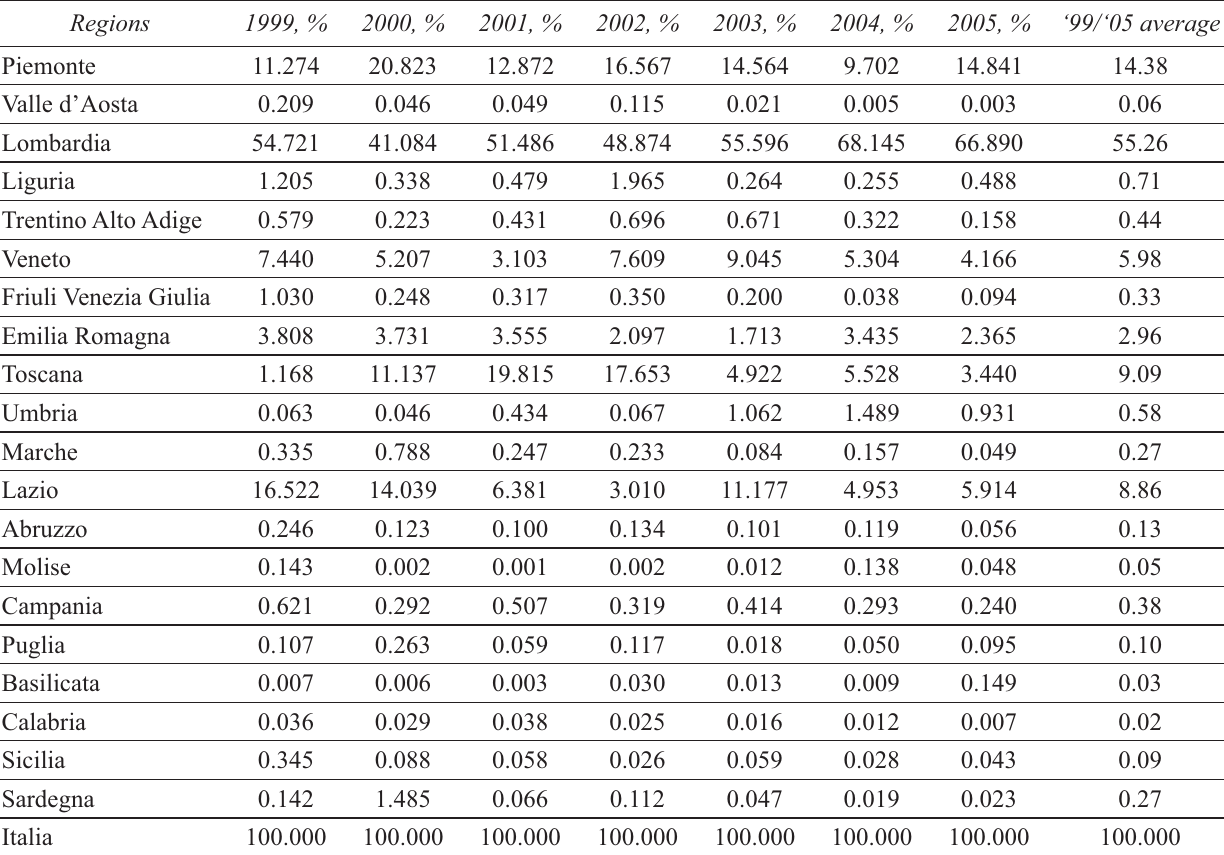
Table 3. Regional distribution of the Italian infl ow of FDI between 1999 and 2005 (in terms of percentage) Regions 1999, % 2000, % 2001,